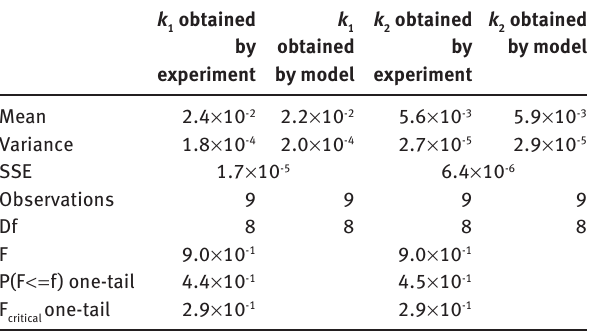
Table 7 F-test of the two sample variance for k ficients for both the experiment and model.